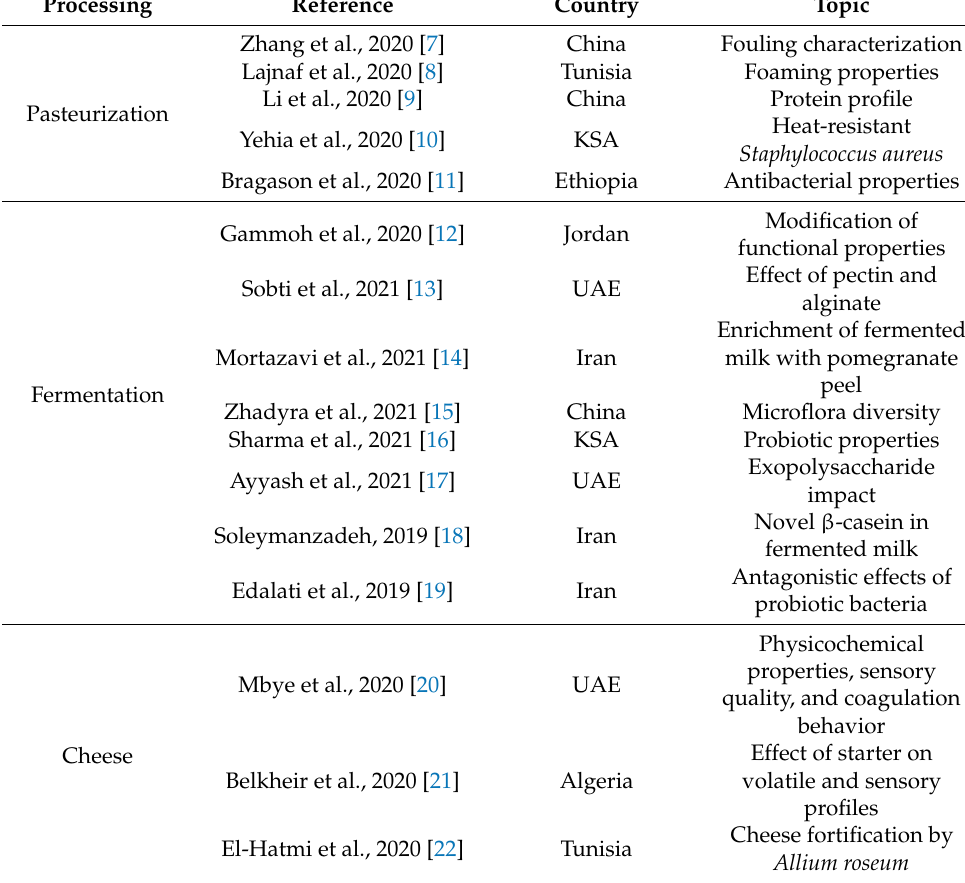
Table 1. The main recent references (2019–2021) regarding camel milk processing. KSA, Kingdom of Saudi Arabia; UAE, United Arab Emirates; USA, United States of